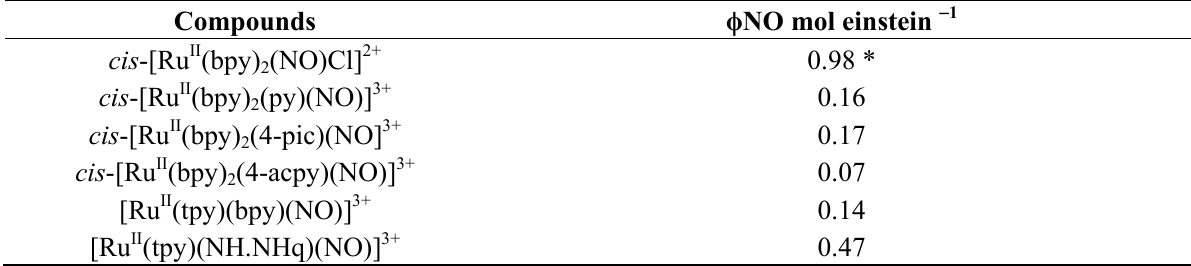
Table 2. Quantum yield ( ϕ NO) values for the nitrosyl polypyridine ruthenium complexes after flash photolysis at 355 nm and pH= 2.01 in trifluoroacetate buffer